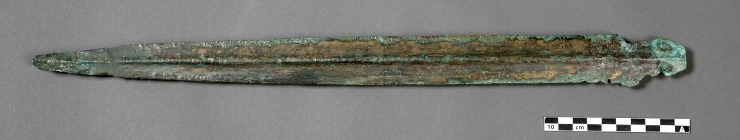
Image of the bronze sword of the “Rixheim” type from the Jestrup male grave.(Photo: Klaus Madsen, courtesy of Museum Thy).